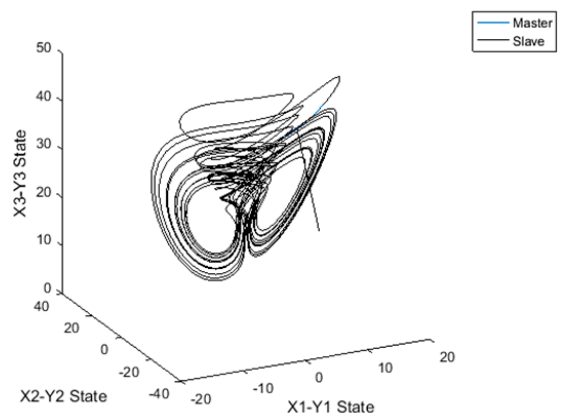
Figure 5. Phase space of synchronization of master–slave system with fractional order given by c = 0.9, c1 = 0.8, c2 = 0.7.